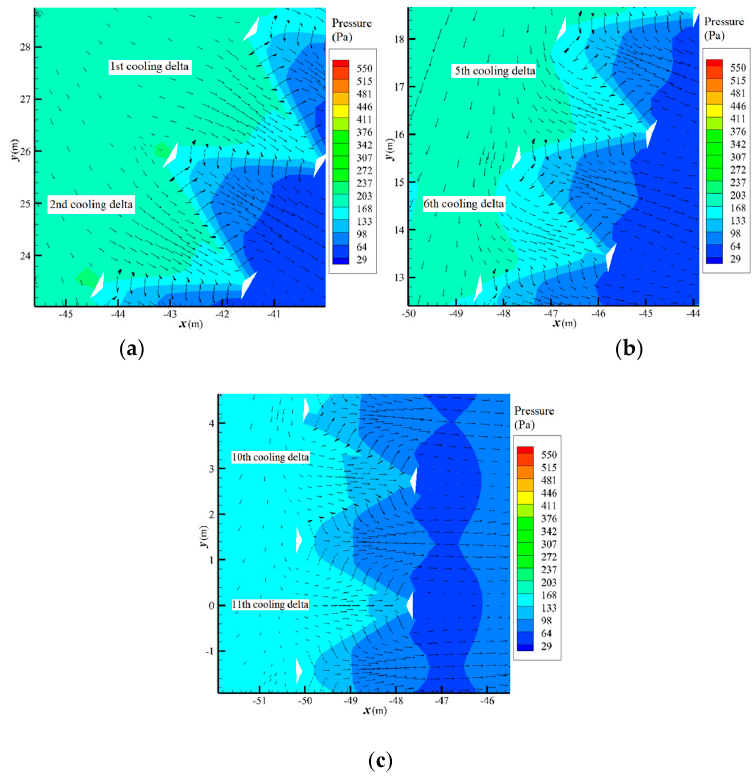
Figure 10. Air flows of representing deltas in rear sector under crosswind of 16 m/s, ( a ) 1st and 2nd delta in rear section; ( b ) 5th and 6th delta in rear section; ( c ) 10th and 11th delta in rear section. Meanwhile, as the wind speed increases, the freezing risk also becomes more serious. However, with a crosswind of 16 m/s, the first two deltas have higher pressure differences than the middle ones, and the last 10th and 11th deltas display much recovered air flow fields than the 5th and 6th deltas